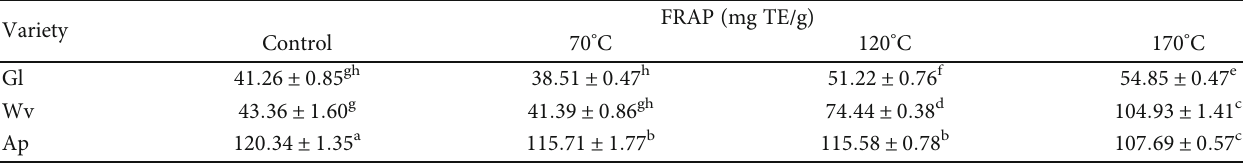
Values are presented as mean ± SD , n = 3 . Values having the same superscript letters are not signi fi cantly di ff erent ( p > 0 : 05 ). Scienti fi c names of the leafy vegetables have been abbreviated as follows: Gl: Gymnema lactiferum ; Wv: Wattakaka volubilis ; Ap: Argyreia populifolia . Table 6: DPPH radical scavenging activity of thermally treated leafy vegetables (DW). Variety